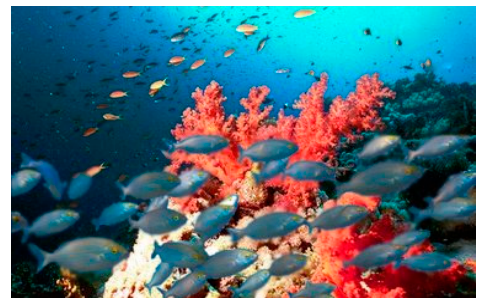
Figure 2. Pictures and descriptions of the status quo of marine biodiversity at Lastovo Islands, and visualization and description of management Scenarios 1 ( a ) and 2 ( b ) (source: own pictures and